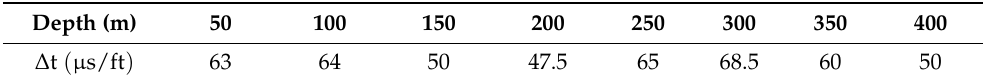
Table 2. Transit time through